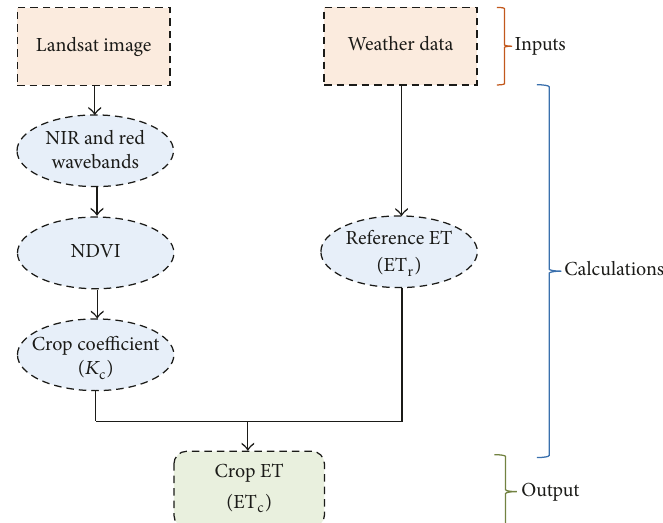
Figure 2: Flowchart of crop evapotranspiration estimation using vegetation index